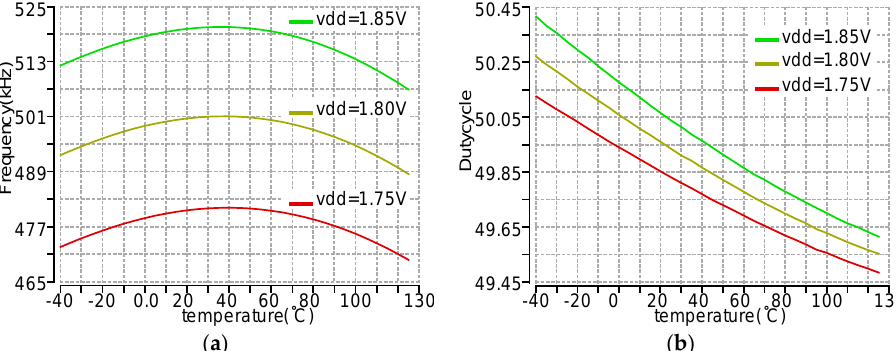
Figure 20. The simulation results of the RC oscillator with a temperature range of −40 to 125 °C and vdd range of 1.75–1.85 V. ( a ) Frequency output. ( b ) Duty cycle.